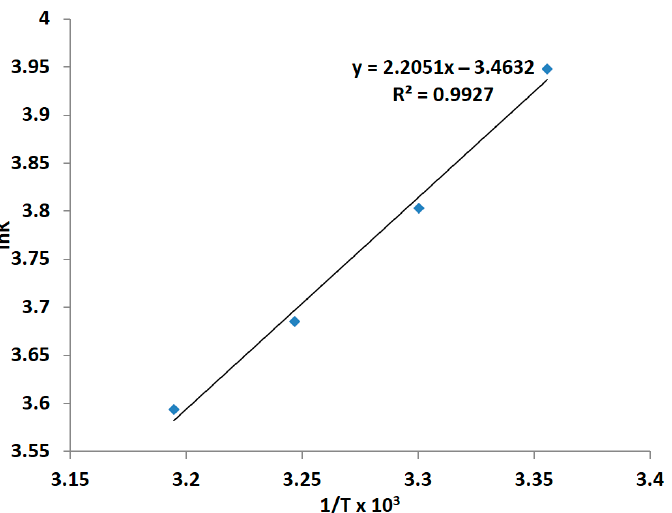
Figure 11. Arrhenius plot for Cu during bacterial leaching of PCB, pH 2.0 at 8% pulp density in the temperature range 298–313 K.